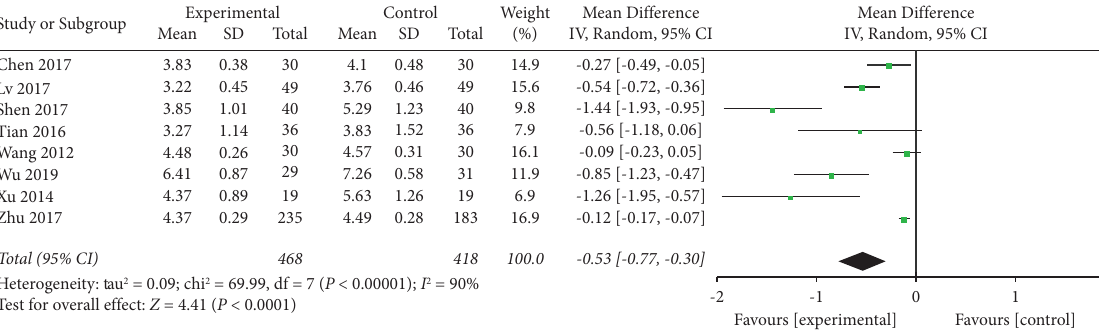
Figure 4: Comparison of the VAS at 12h between the AA group and the control group.